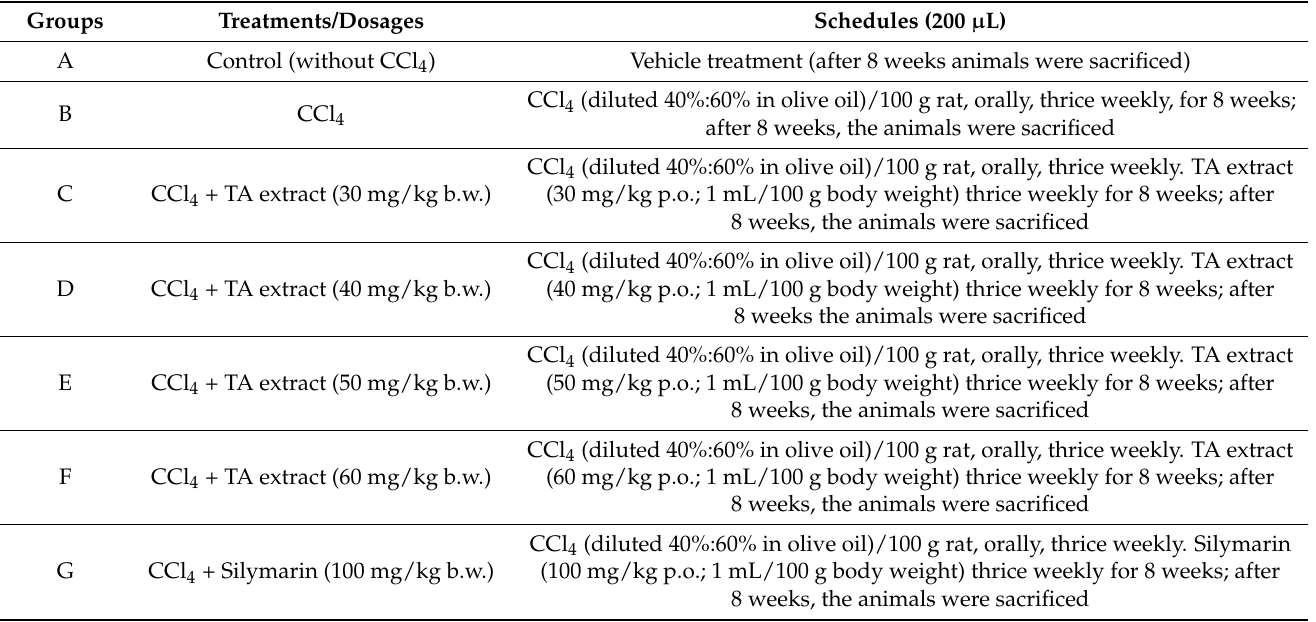
Table 3. Dose optimization of TA extract. Forty-two Wistar male rats were divided into seven groups containing six animals each. Group A was designated as normal without any chemical or extract treatment. Group B was designated as the CCl 4 -treated group and the animals were administered 40% CCl 4 mixed in olive oil orally for 3 alternate days a week for 8 weeks. Groups C, D, E, and F were administered 40% CCl 4 mixed in olive oil and 30, 40, 50, and 60 mg/kg b.w. TA extract, respectively, and all treatments were administered for 3 alternate days a week for 8 weeks. Group G was designated as 40% CCl 4 mixed in olive oil and standard silymarin 100 mg/kg orally for 3 alternate days a week for 8 weeks.